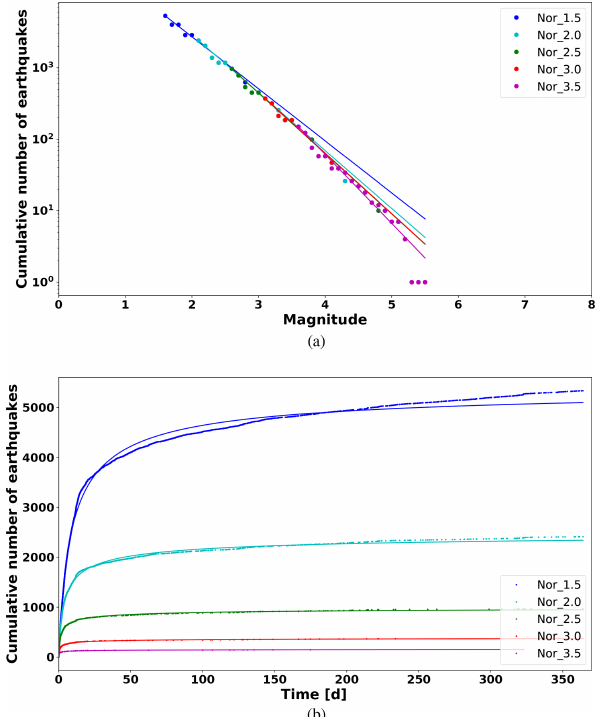
Figure 3. Fitting of the (a) GR law and (b) MO law to the Northridge aftershocks (NOR) considering different minimum magnitudes: M min , 1.5 (dark blue markers), 2.0 (turquoise), 2.5 (green), 3.0 (red), and 3.5 (pink),